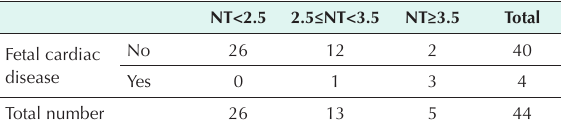
Table 2 . Relationship Between NT Thickness and Fetal Cardiac Disease